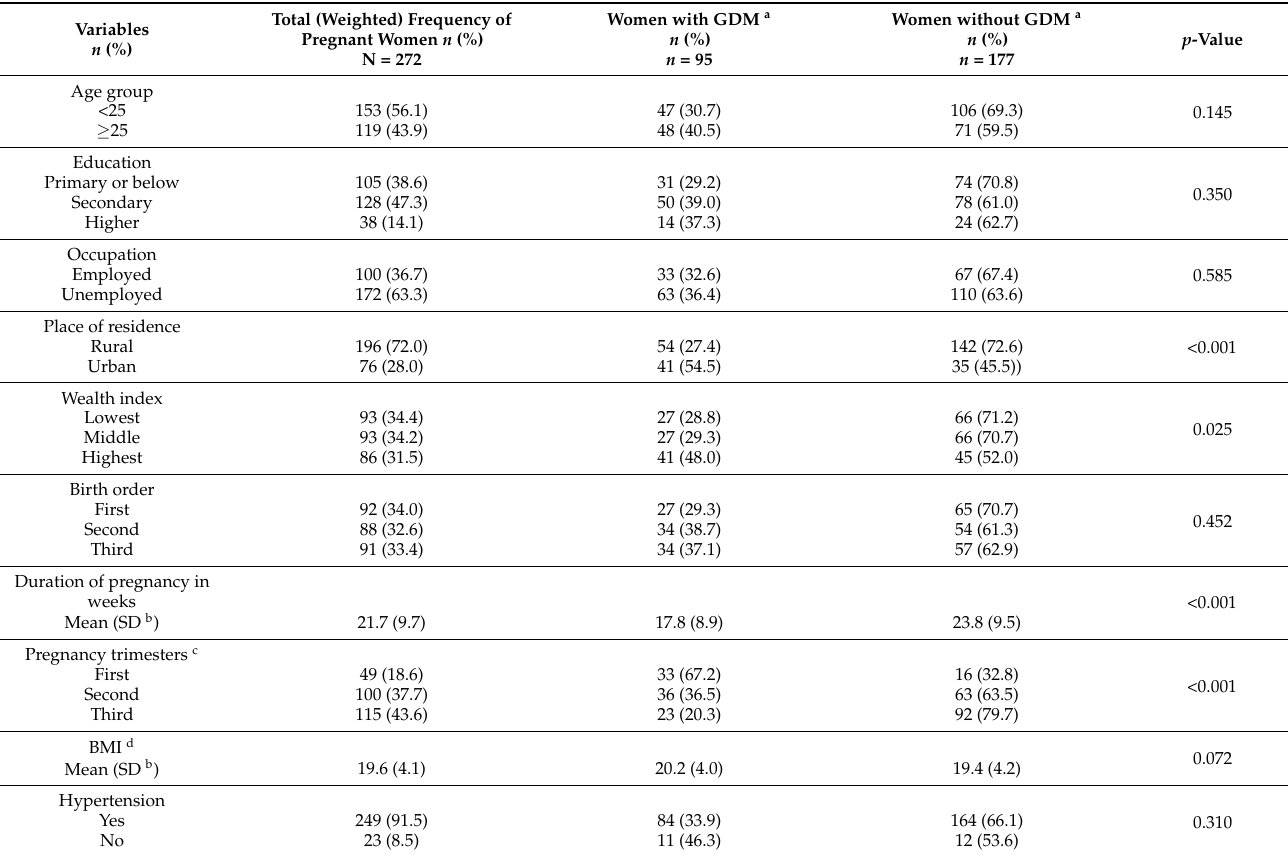
Table 1. Sociodemographic and pregnancy characteristics of the study participants and prevalence of gestational diabetes